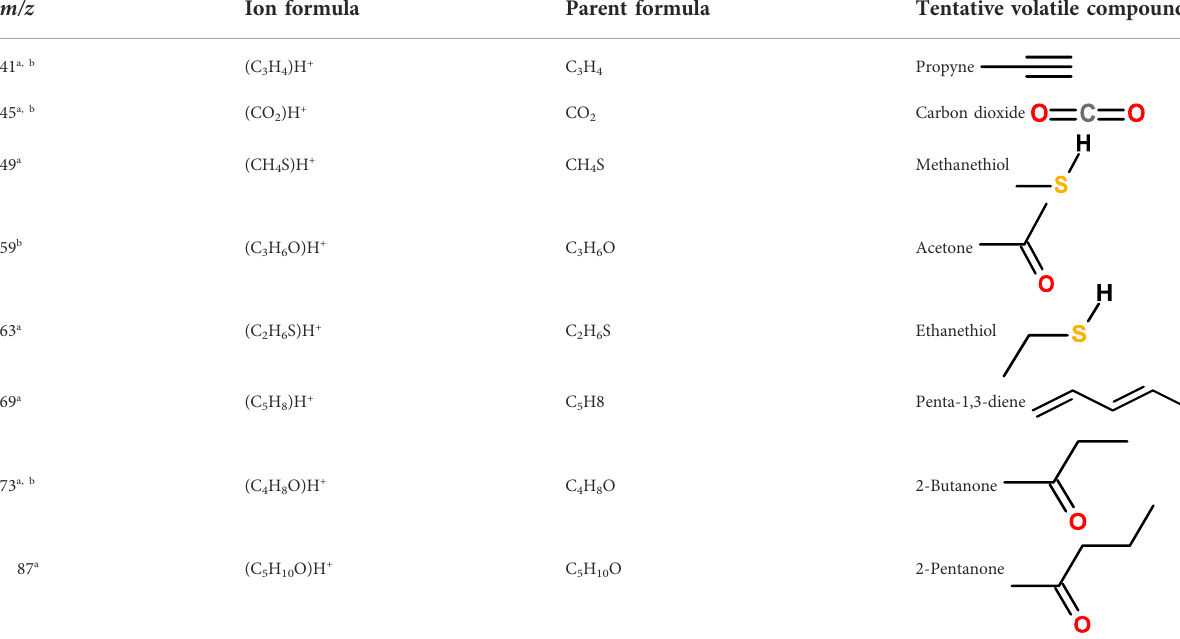
TABLE 2 Tentative volatile compounds detected during the biodegradation of 1,10-decanedithiol